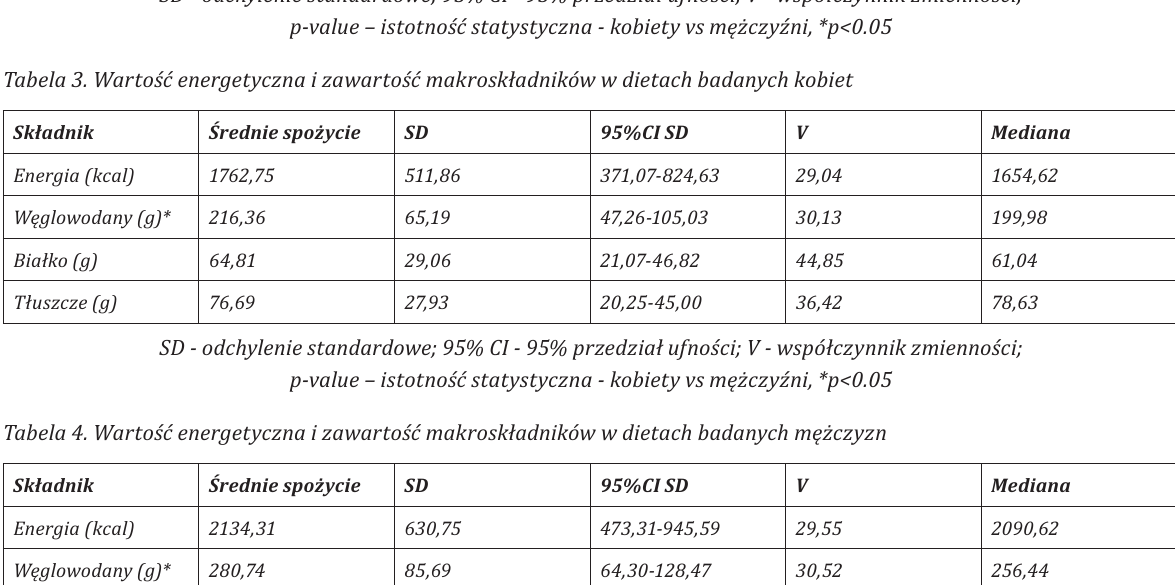
Tabela 5. przedstawia spożycie tłuszczu oraz poszczególnych frakcji kwasów tłuszczowych wśród ankietowanych. W przeprowadzonym badaniu średnie